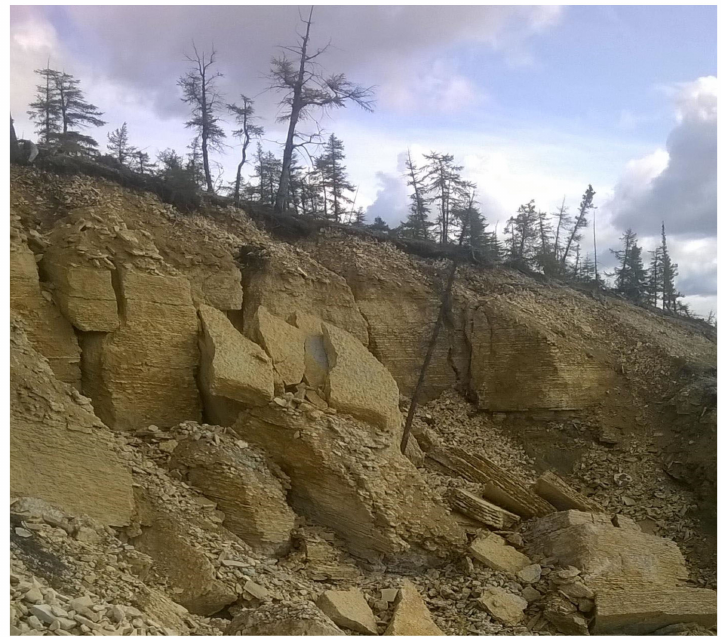
Figure 4. Silurian limestones broken by fracture